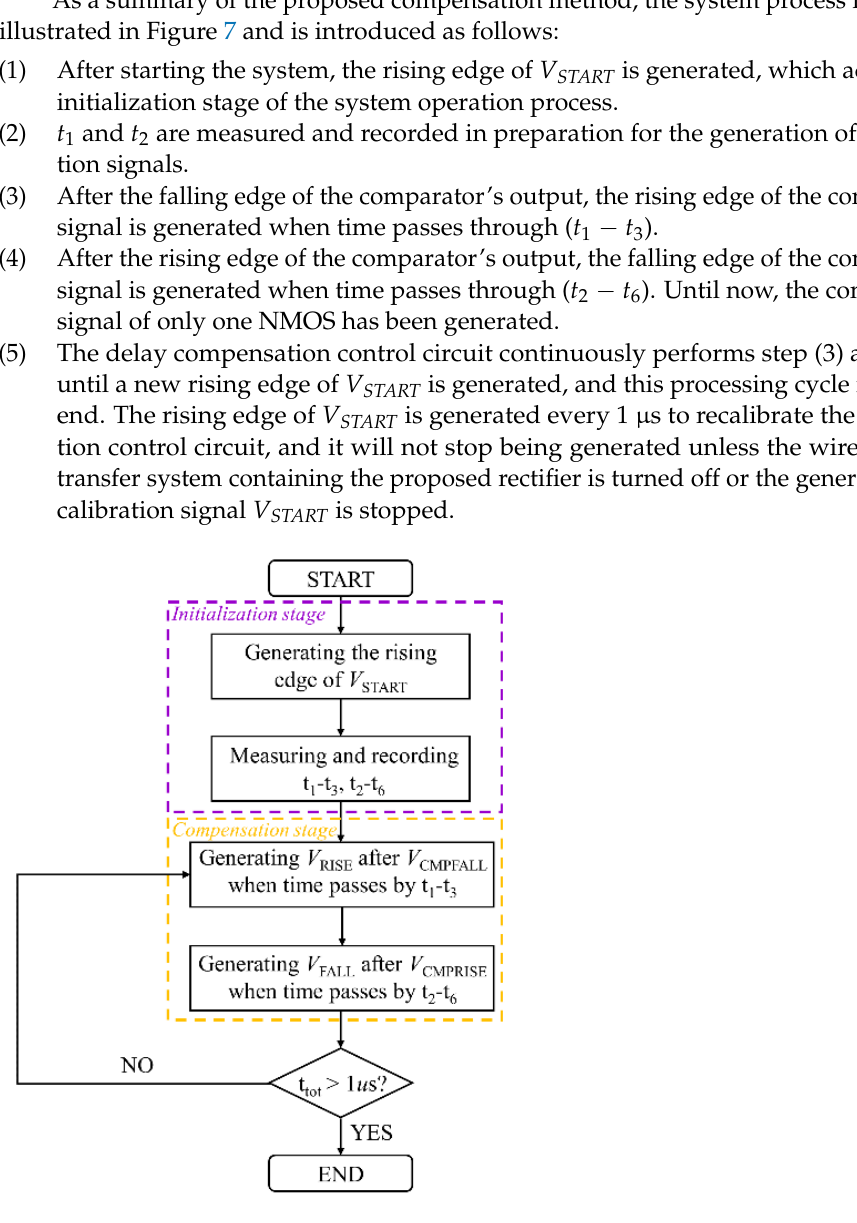
Figure 7. The flowchart of the proposed compensation method in one cycle.